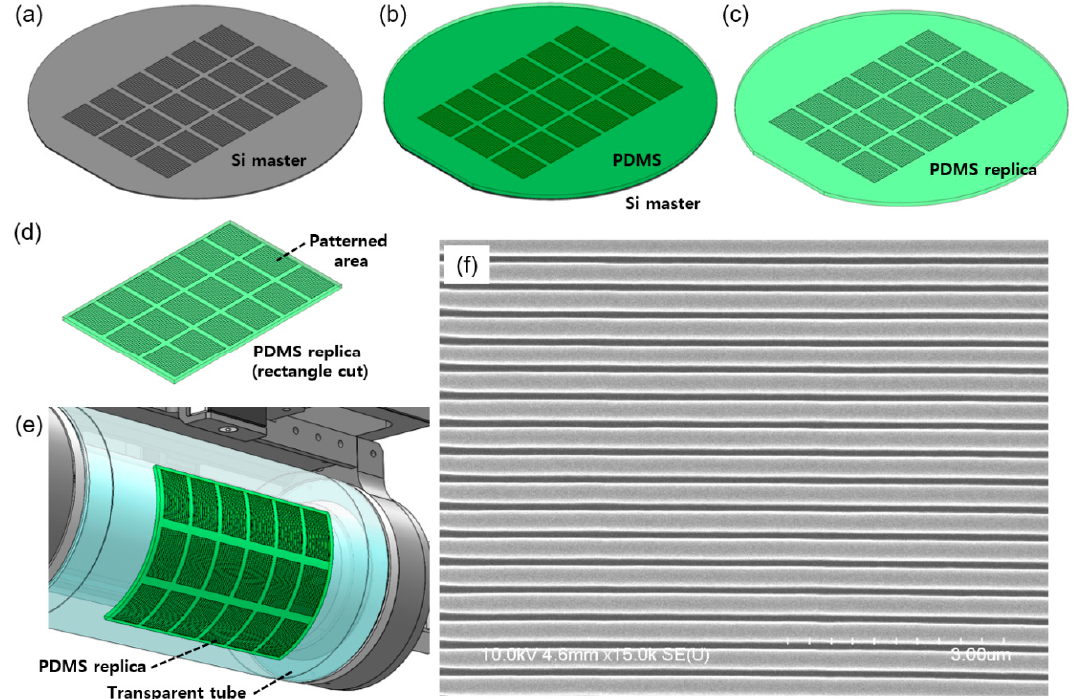
Figure 5. Fabrication of the PDMS stamp roll. ( a ) A nanopatterned Si template; ( b ) PDMS poured on the Si template; ( c ) PDMS replica; ( d ) rectangle cut PDMS replica; ( e ) the PDMS replica mounted on the transparent tube; ( f ) SEM image of the nanolines on the PDMS replica.